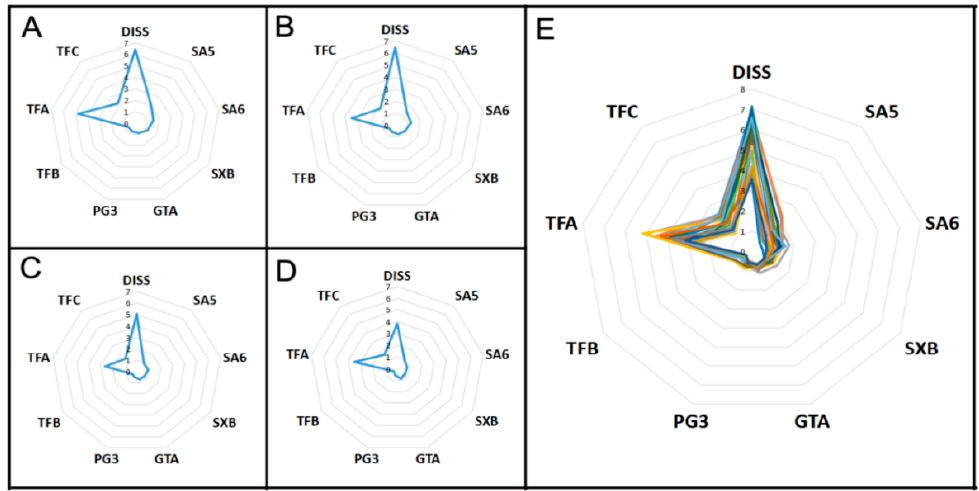
Figure 4. Radar plots showing the difference of geographical origins in terms of nine components in various P. tenuifolia samples; ( A ) G1; ( B ) G2; ( C ) G3; and ( D ) G4. E : the distribution of the chemical composition patterns of 23 P. tenuifolia samples. Note: DISS: 3,6 ′ -disinapoyl sucrose; SA5: sibiricose